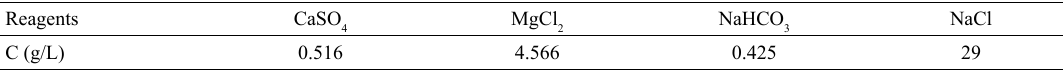
Table 2. Chemical composition of the used electrolyte calculated for 1 L of distilled water.